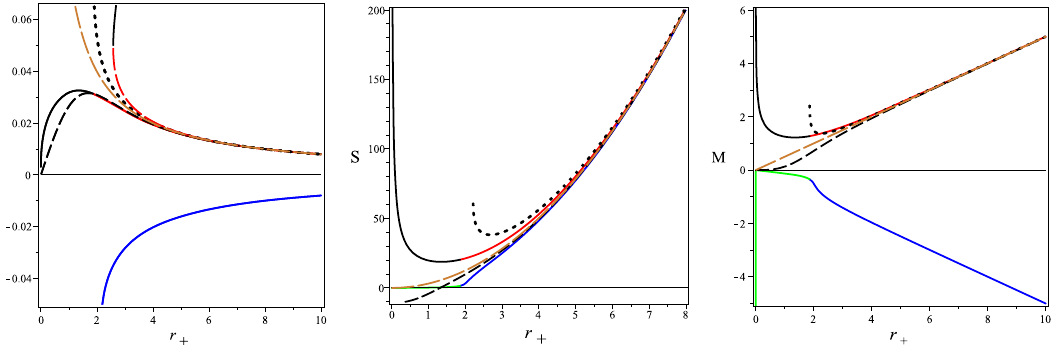
Fig. 2 The temperature, entropy and mass as a function of r + for c 1 = − 0 . 25 ,α = 0 . 5: solid lines are the results of our method and dashed lines are the results of the paper [17,18]. For α = − 0 . 5: Fig. 3 The free energy and heat capacity as a function of r + for c 1 = − 0 . 25 ,α = 0 . 5. The orange long dashed lines related to the Schwarzschild’s black hole